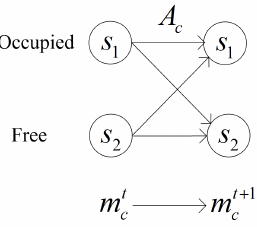
Figure 1. Markov chain for one